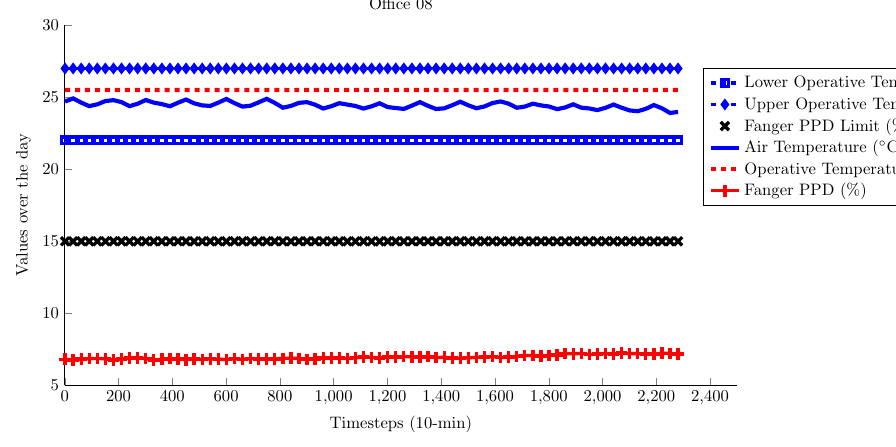
Figure 8. Summer results for Office 08 using the operative temperature thermostat set at 25.5 ◦ C.